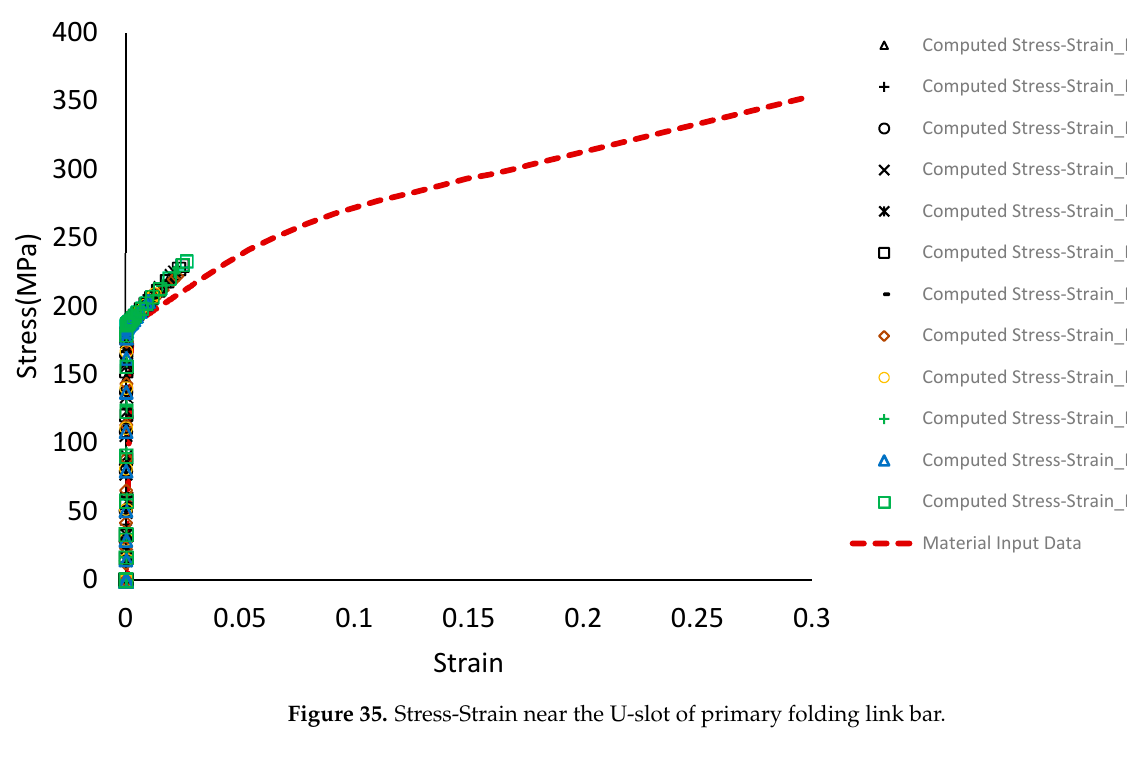
Figure 34. PEEQ value for the link assembly for a factored gravity loading of 4 kPa.